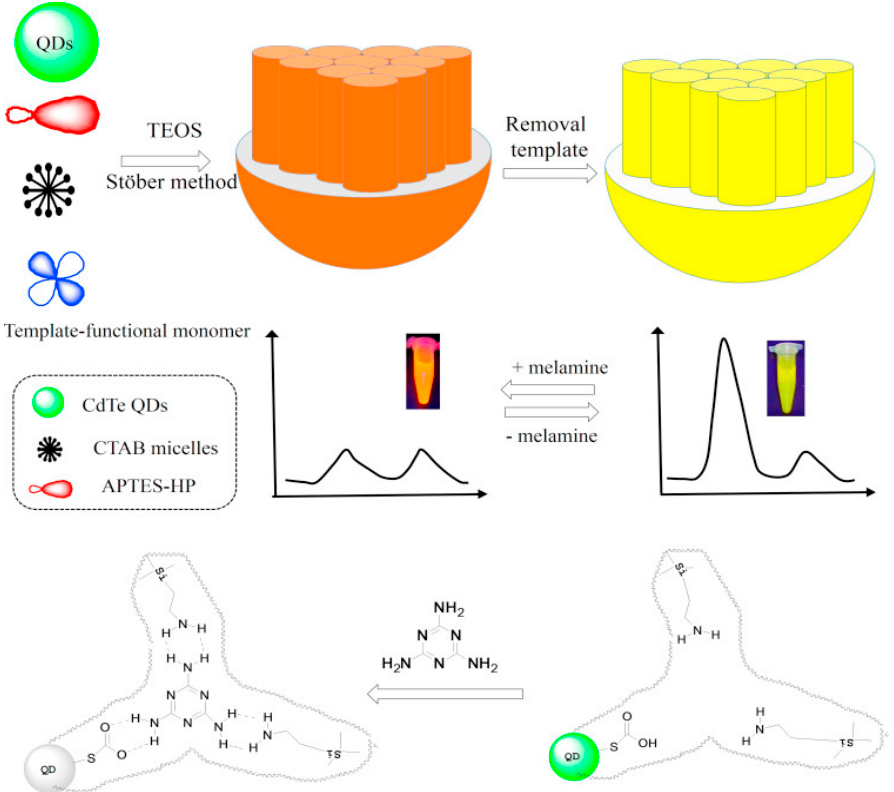
Figure 4. Schematic illustration for the one pot preparation of mesoporous structured ratiometric fluorescence of molecularly-imprinted polymers (MIPs) probe (reproduced with permission from Reference [40]).